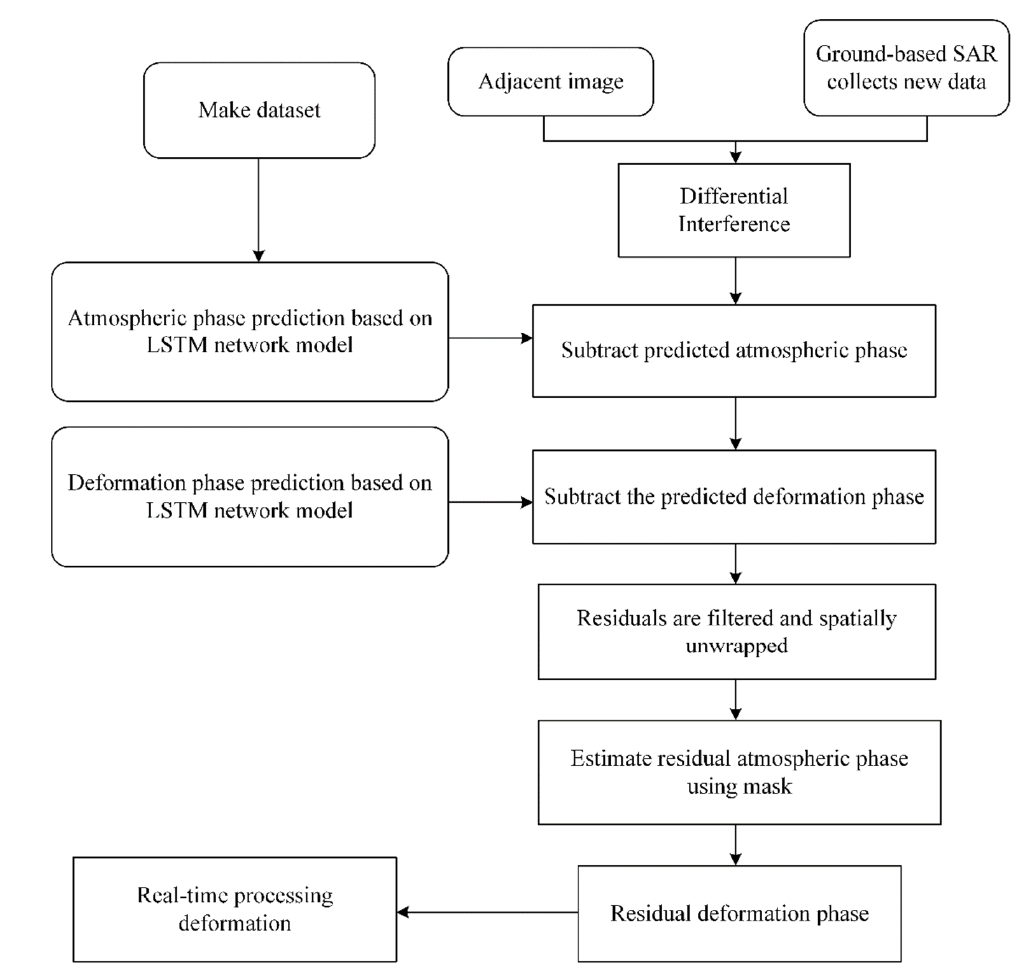
Figure 3. The technical roadmap of GB-InSAR time series processing method based on LSTM model.